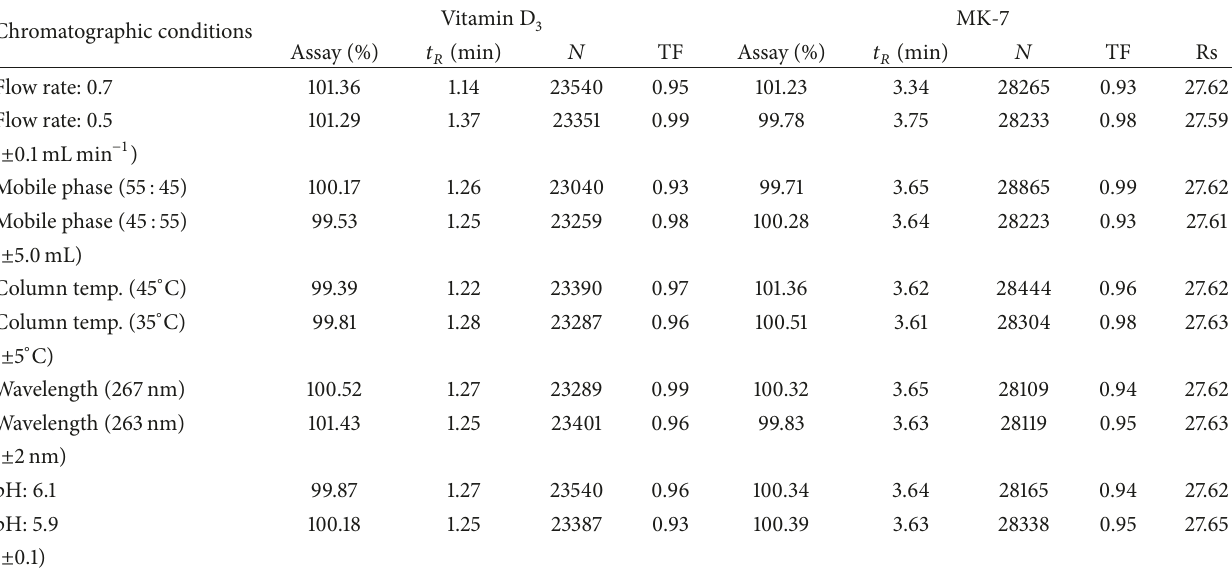
Table 6: Robustness study of vitamin D 3 and MK-7 by UHPLC.